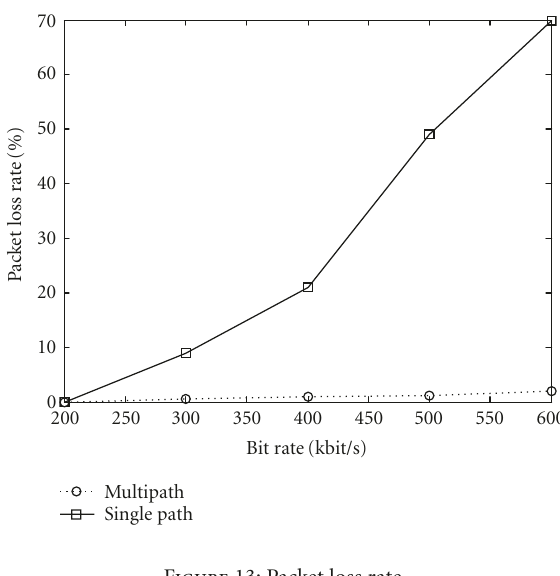
Figure 12: Average PSNR. Figure 13: Packet loss